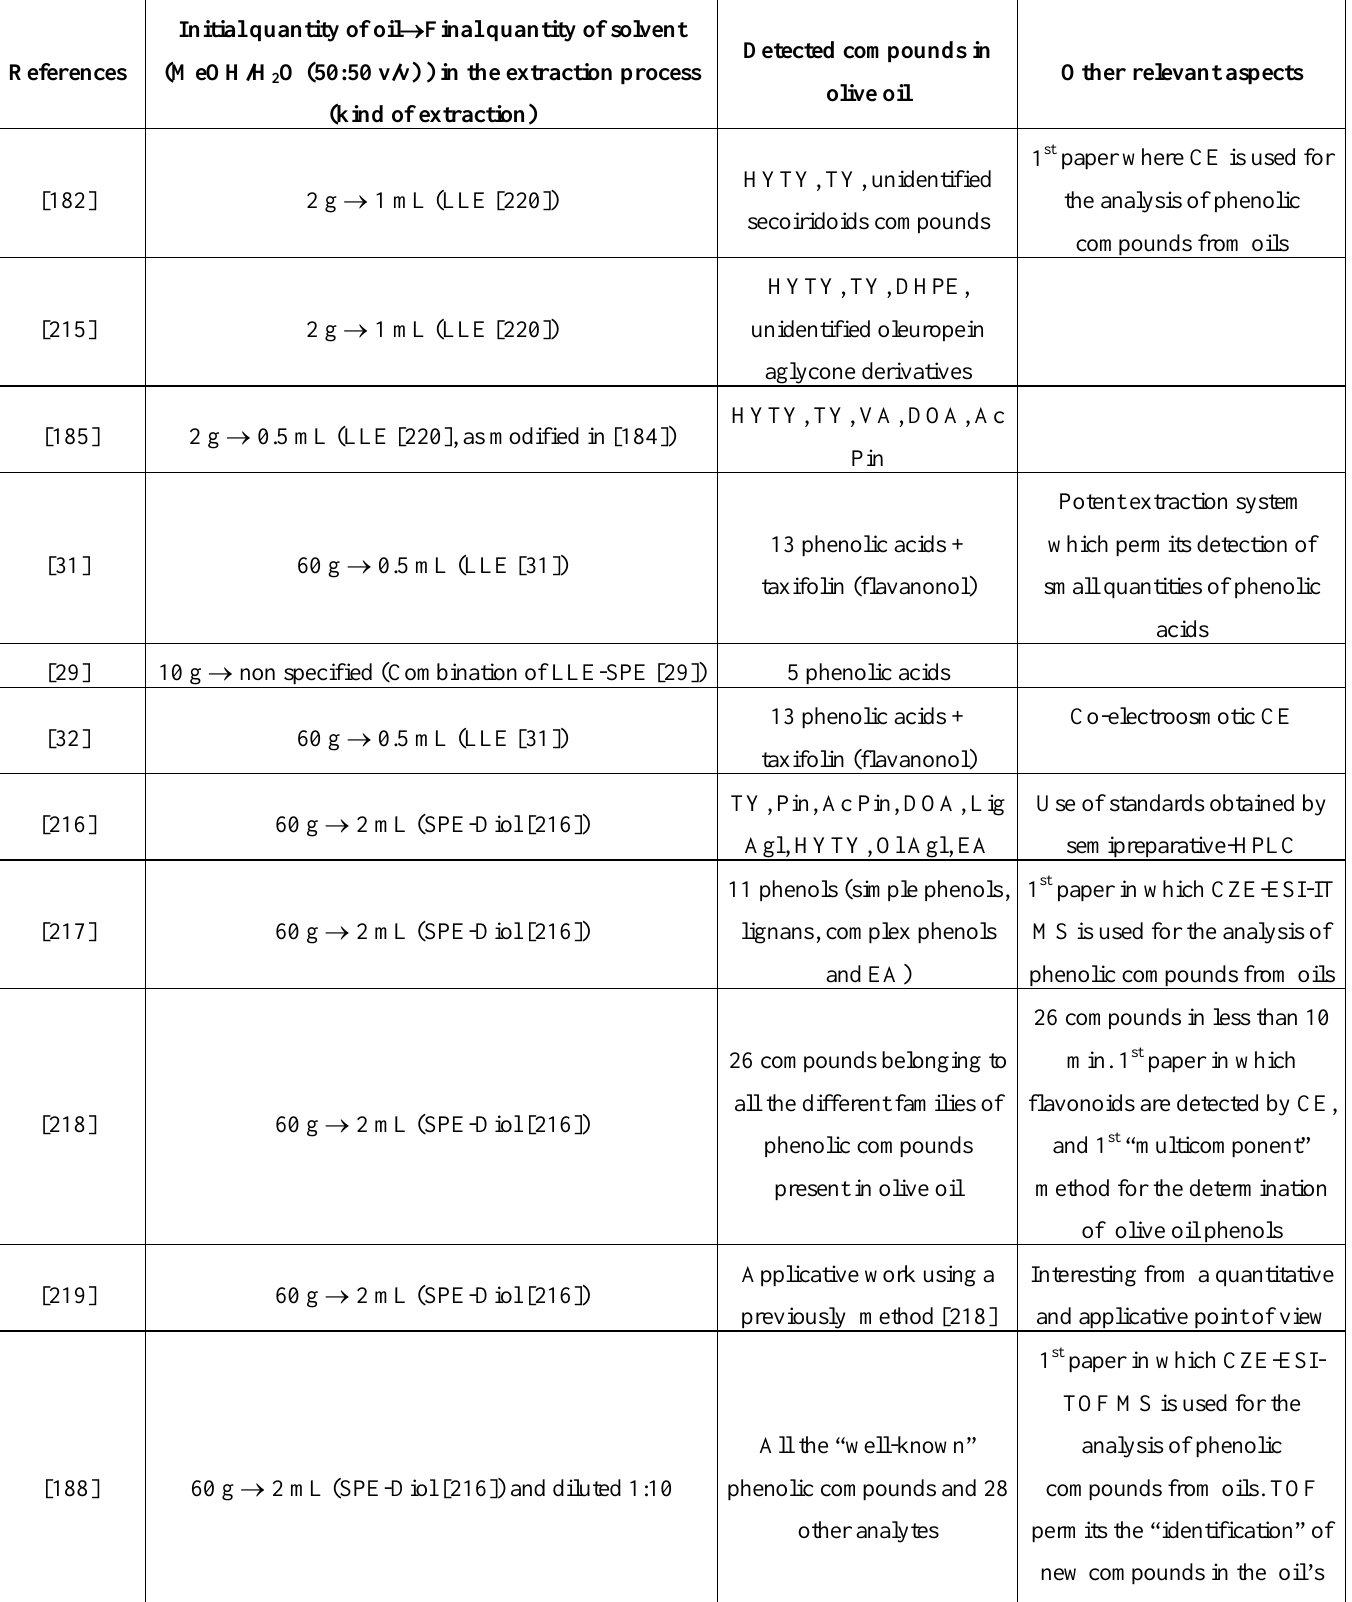
Table 5. Summary of extraction systems used and compounds detected in VOO samples with the application of each method. HYTY, hydroxytyrosol; TY, tyrosol; DHPE, 2,3-dihydroxyphenylethanol; VA, vanillic acid; DOA, decarboxymethyloleuropein aglycon (3,4-DHPEA-EDA); Ac Pin, (+)-1- acetoxypinoresinol; Lig Agl, ligstroside aglycone; Ol Agl, oleuropein algycone; EA, elenolic